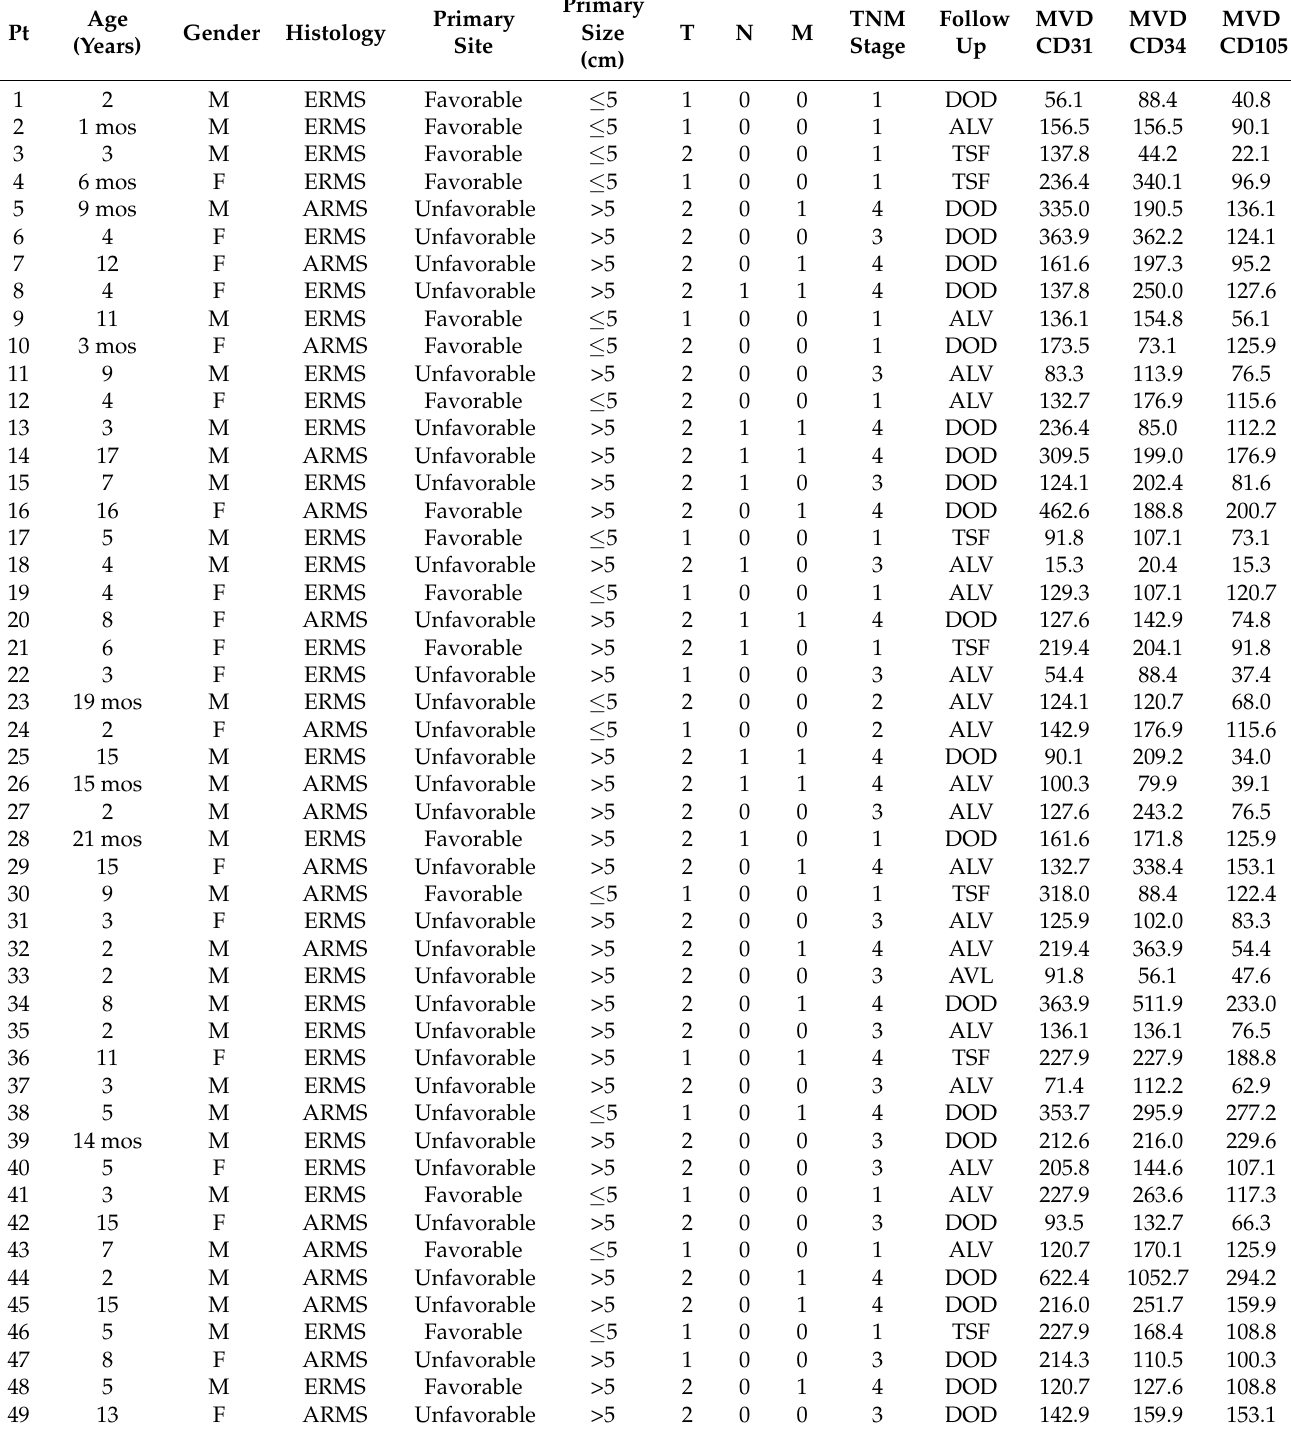
Table 1. Characteristics of 49 participants with